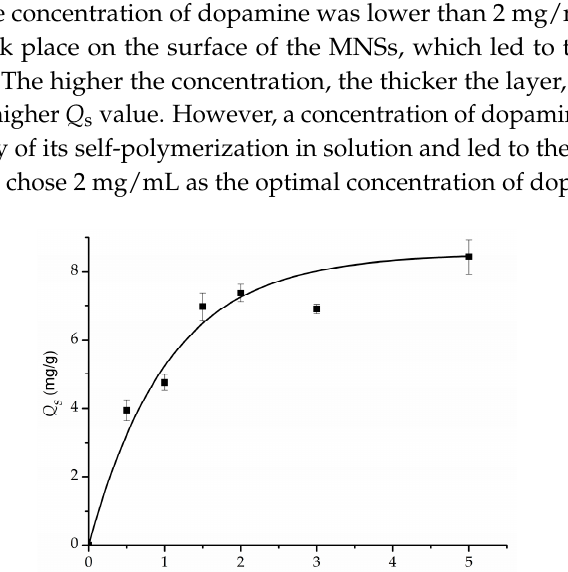
Figure 4. Effect of amount of hypericin (% of dopamine in mole) on specific absorption capacity ( Q s ).